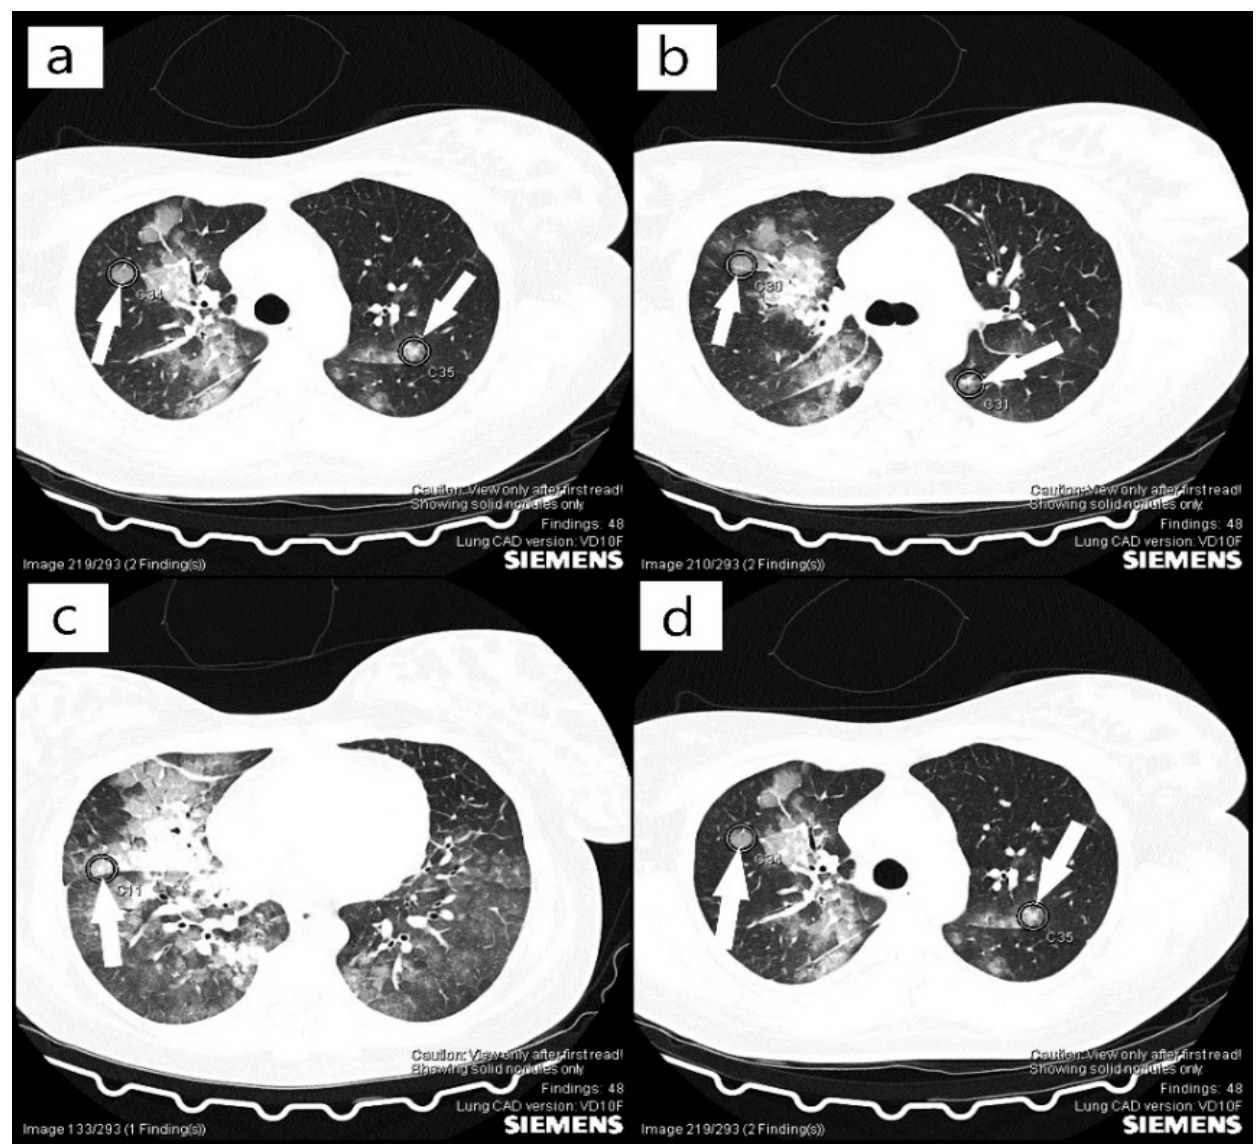
Figure 2. ( a – d ) Computer tomography (CT) scan with pulmonary microthrombosis (arrows).